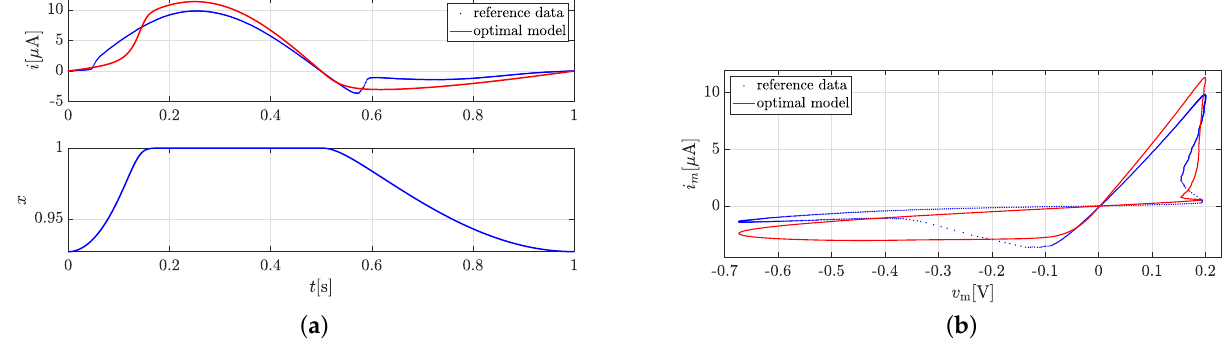
Figure 8. Results of the optimization using the asymmetric Strukov model with Biolek window for the same reference data presented in Figure 7. F ( x ) = 5.7900 × 10 − 2 . ( a ) Comparison graph of the memristor current obtained from the model and the reference data, and the internal variable x ( t ) ; ( b ) Corresponding i m − v m